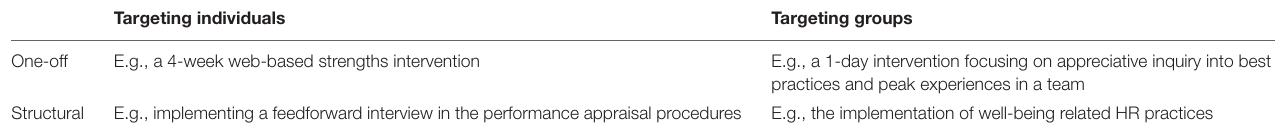
TABLE 1 | Types of positive psychology interventions in organizations. Targeting